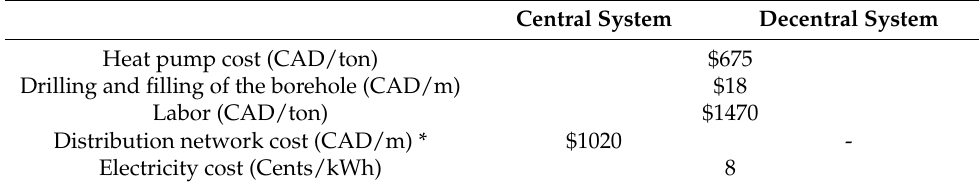
Table 3. Costs of the items for economic